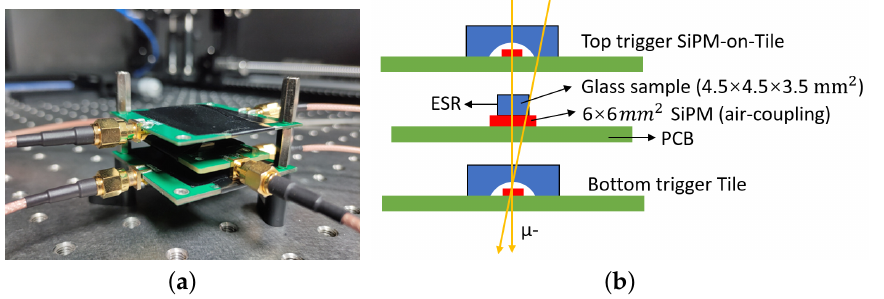
Figure 8. The experimental setup used for the cosmic ray test. ( a ) is the real experimental setup and ( b ) is the schematic of the experimental setup.